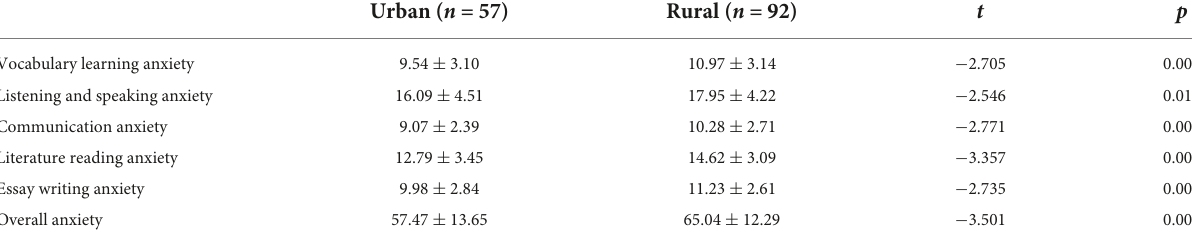
TABLE 7 Geographical backgrounds test in English learning anxiety of medical students.